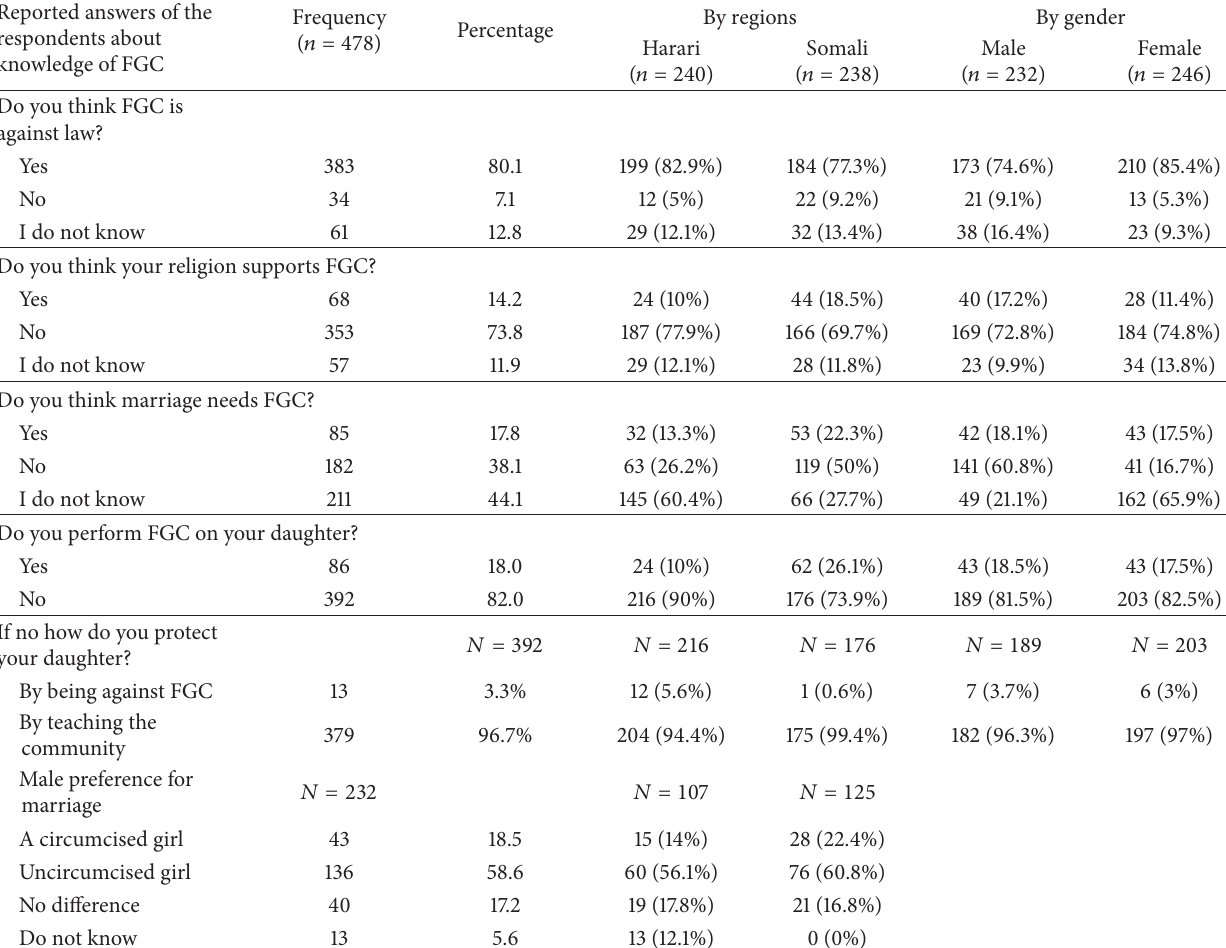
Table 4: Knowledge of respondents about FGC in Somali and Harari regions, Eastern Ethiopia.